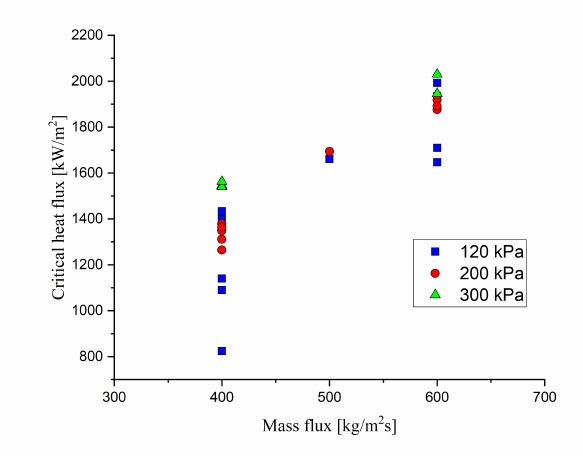
Figure 13. Results of the